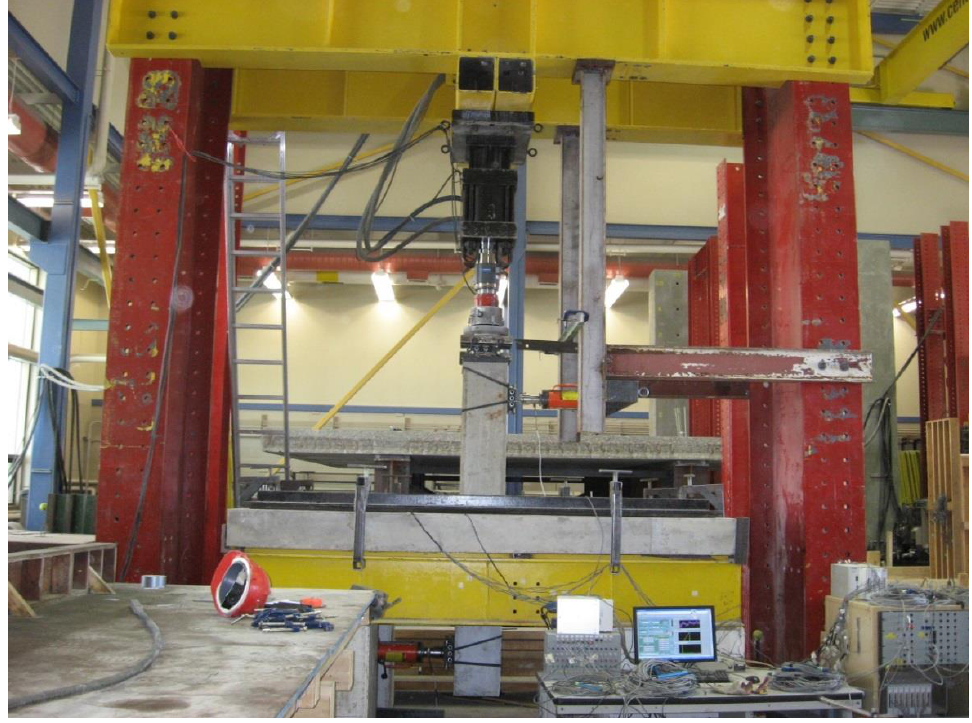
Figure 2. Test setup.